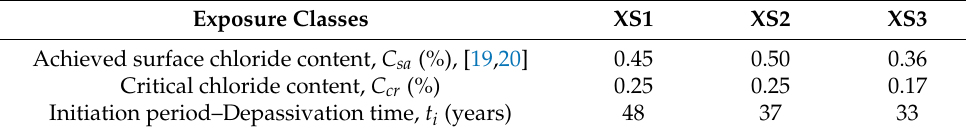
Table 2. Input parameters and initiation period for different exposure